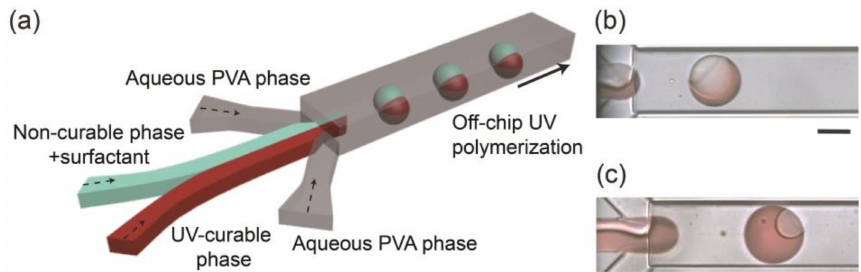
Figure 1. Microfluidic formation of biphasic Janus droplets. ( a ) Schematic illustration of a microfluidic Janus droplet generator with a deeper drainage region. ( b , c ) Formation of Janus droplets when flow rate ratios of acrylate monomer ( Q m ) and silicone oil ( Q s ) are ( b ) Q m : Q s = 1:1 and ( c ) Q m : Q s = 11:1. Total flow rate of the two droplet phases ( Q d, total = Q m + Q s ) is 0.6 mL h − 1 , and the flow rate of the aqueous polyvinyl alcohol (PVA) phase ( Q c ) is 8.0 mL h − 1 (4.0 mL h − 1 × 2). Scale bar: 100 µ m.